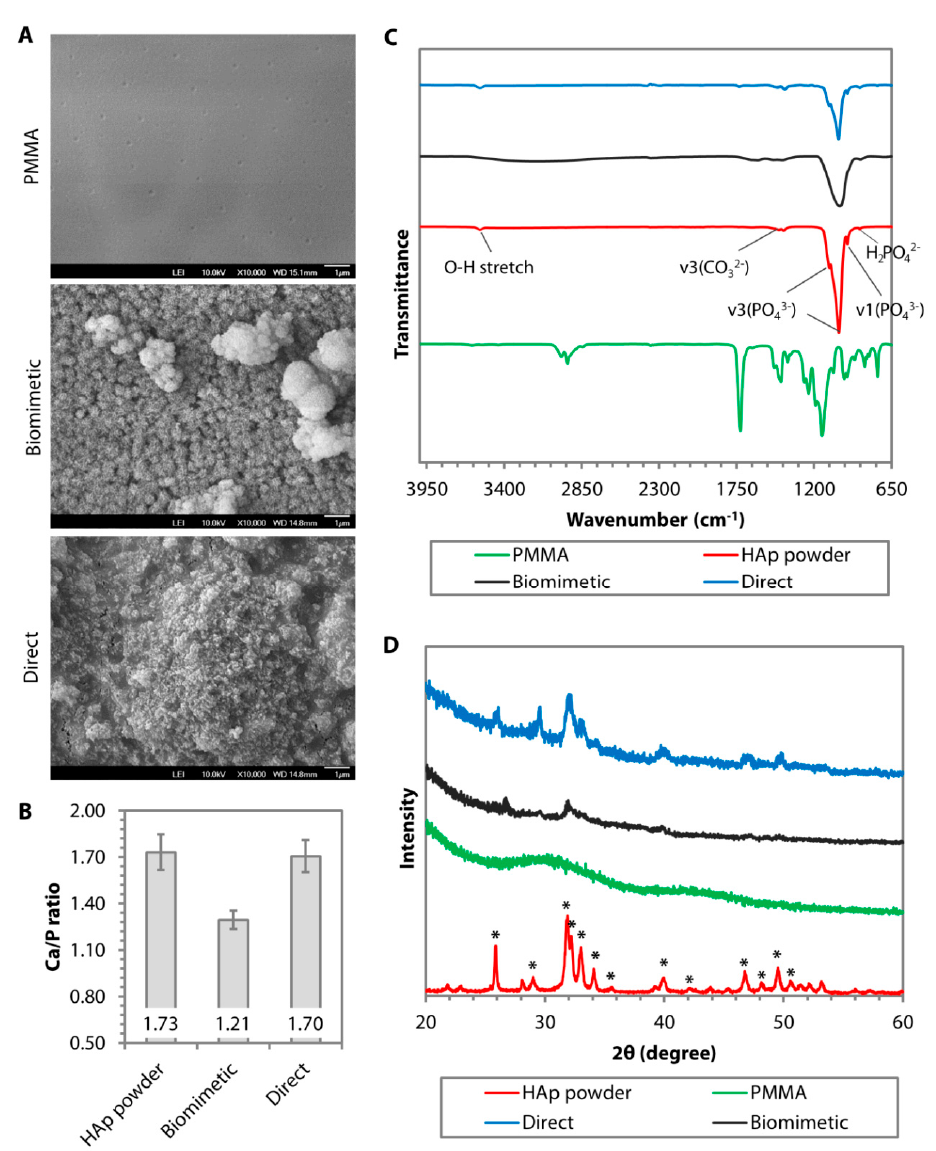
Figure 2. Comparison of surface morphology, chemical composition, phase, and crystallinity of hydroxyapatite (HAp) coating deposited on poly(methyl methacrylate) (PMMA) via biomimetic deposition or direct immobilization approach. ( A ) Scanning electron microscopy (SEM) images of PMMA surface before and after HAp coating via biomimetic deposition or direct immobilization technique. ( B ) Ca/P ratio generated from the energy dispersive X-ray (EDX) of calcined HAp (stoichiometric HAp) and the resulting CaP minerals deposited on the PMMA. ( C ) Fourier transform infrared (FTIR) patterns of uncoated PMMA (in green) and stoichiometric HAp (in red) showed a distinct IR band difference between the groups. A peak of v3(PO 43 − ) was found in after either biomimetic (in black) or direct (in blue) deposition. However, the other v3(PO 43 − ) and v1(PO 43 − ), which were typical of stoichiometric HAp, could only be seen in the direct deposition group. ( D ) Graze incidence-X-ray diffraction (GI-XRD) pattern revealed that the calcined HAp powder exhibited the prominent characteristic peaks of pure HAp according to JCPDS no. 00-009-0432. Most of the peaks also appeared in the direct immobilization group. In contrast, the biomimetic group exhibited an XRD pattern of amorphous octacalcium phosphate